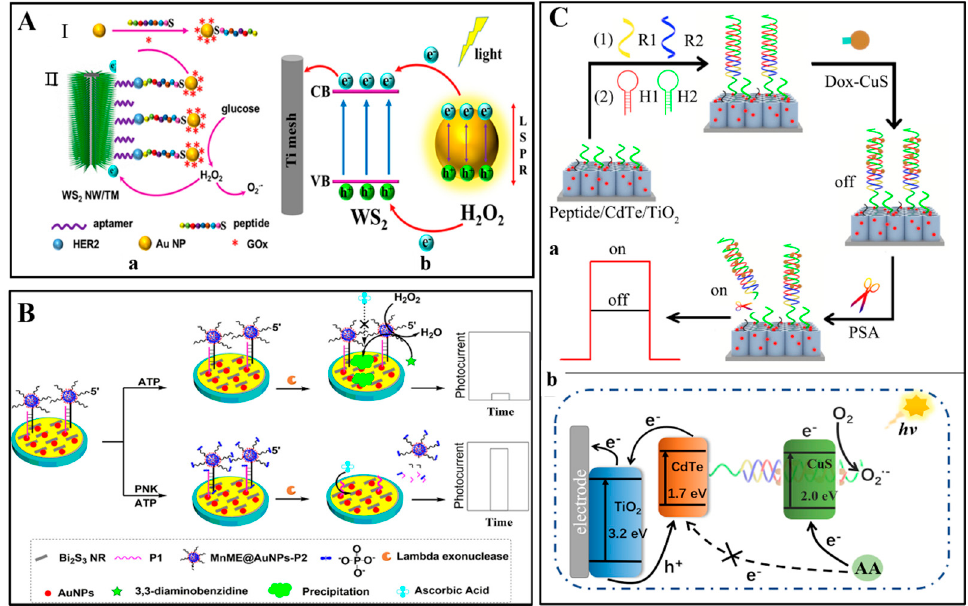
Figure 2. ( A ) (a) The process to fabricate PEC biosensor based on WS 2 nanowire array on Ti mesh (TM) for breast cancer biomarker HER2 detection; (b) Schematic mechanism of the PEC system [50]. Reproduced with permission Copyright 2019, Elsevier B.V. ( B ) A signal-on PEC biosensor for PNK assay with the MnME@AuNPs-P2 catalytic precipitation on Bi 2 S 3 nanorod as the photoactive materials [78]. Reproduced with permission Copyright 2018, American Chemical Society. ( C ) Construction (a) and response mechanism (b) of PEC biosensor based on CuS nanocrystals [73]. Reproduced with